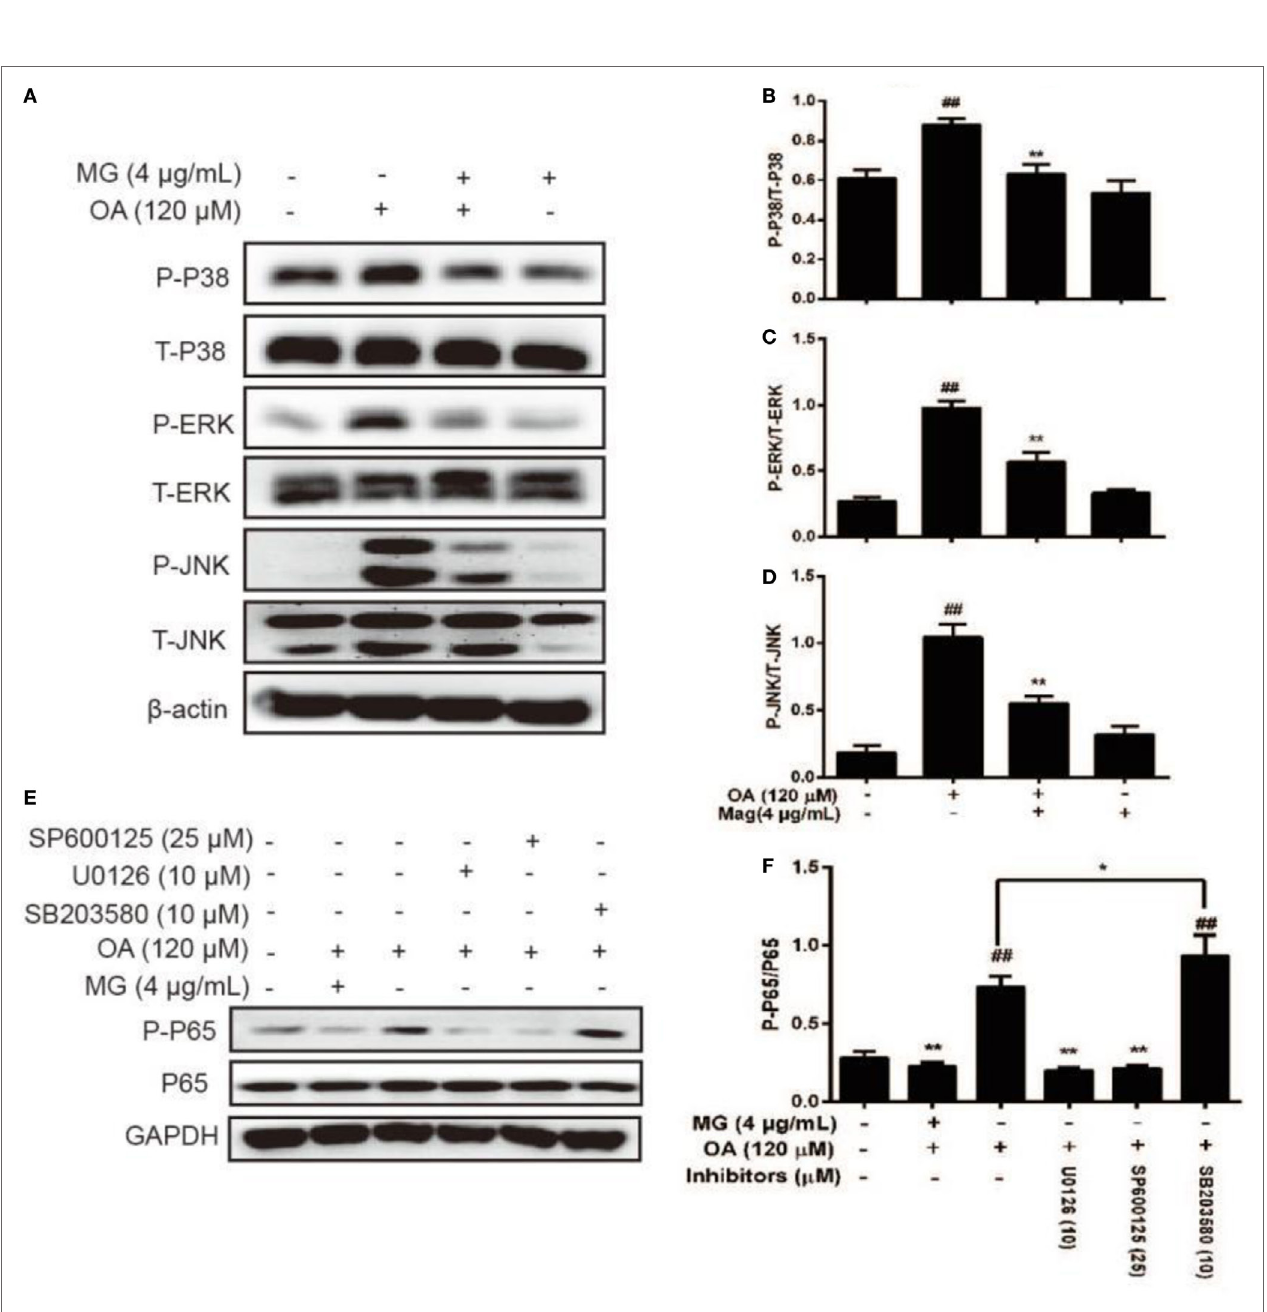
FigUre 6 | Effect of magnolol (MG) on oleic acid (OA)-activation of nuclear factor-kappa B protein expression in HepG2 cells. Cells were exposed to MG (4 µg/mL) with or without OA (120 µM) for up to 24 h. Next, (a) TNF- α production was determined by enzyme-linked immunosorbent assay at 450 nm, and (F) reactive oxygen species release was determined by chemiluminescence assay at excitation and emission wavelengths of 485 and 535 nm, respectively. (B,c) HepG2 cells were cultured with OA (30, 60, 120, 240, and 480 µM) for 24 h. P65 and P-P65 protein expression was detected by western blot. (D,e) Cells were exposed to OA (120 µM) for 6, 12, or 24 h. Protein expression of P-P65 and P65 was measured by western blot. (g–J) At the indicated doses, cells were treated with MG (4 µg/ mL) in the presence or absence of OA (120 µM) for 24 h. Protein expression of P-P65, P65, P-I κ B α , and I κ B α was analyzed by western blot. Quantification of the relative expression of P-P65/P65, P-I κ B α / β -actin, and I κ B α / β -actin was obtained by density analysis. All data are expressed as the mean ± SD of three independent experiments. Statistically significant at # p < 0.05 and ## p < 0.01 vs. the control group and ** p < 0.01 vs. the OA-treated group (one-way ANOVA followed by Tukey’s